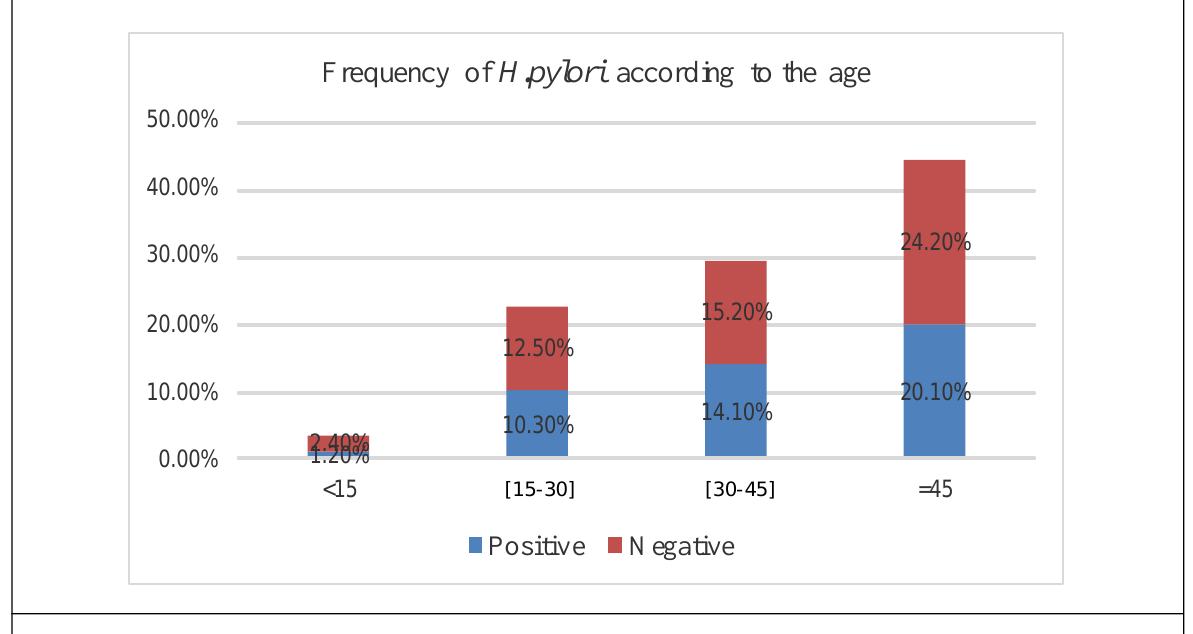
Positive Negative